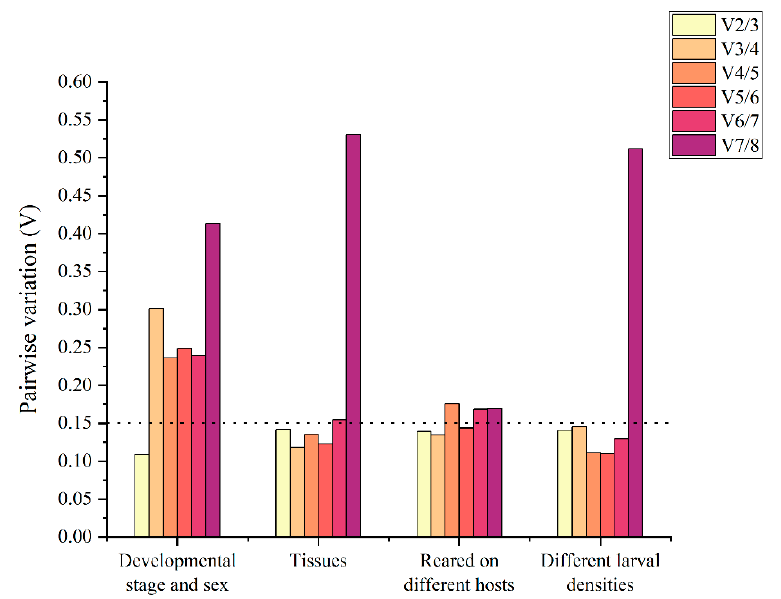
Figure 3. Determination of the optimal number of reference genes according to geNorm. The pairwise variation values below 0.15 indicated that no additional reference gene was needed for the normalization .